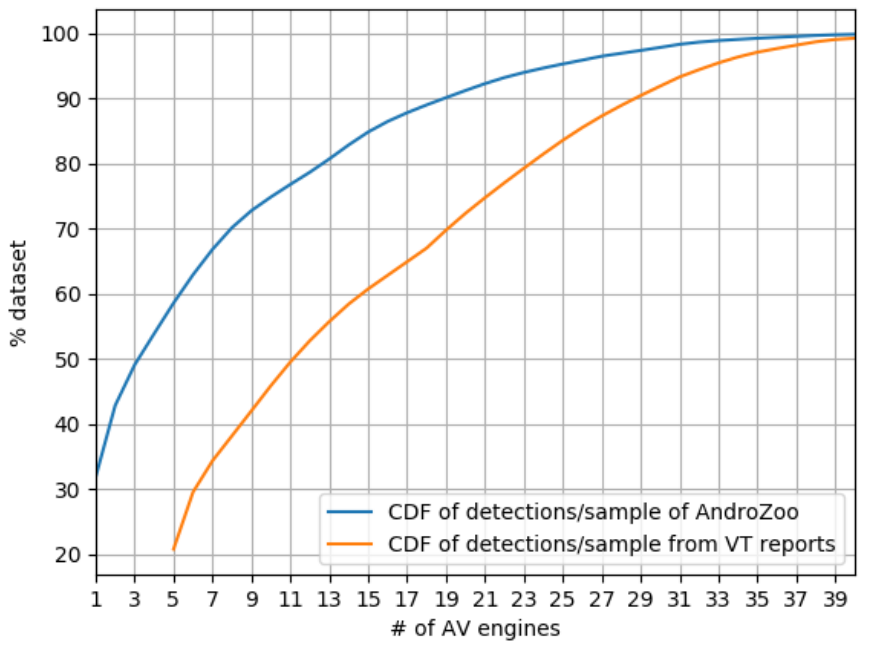
Figure 1. CDF of AV detections for samples in our dataset. x-axis represents # of engines detecting samples; y-axis is the percentage of samples in dataset detected by this # of